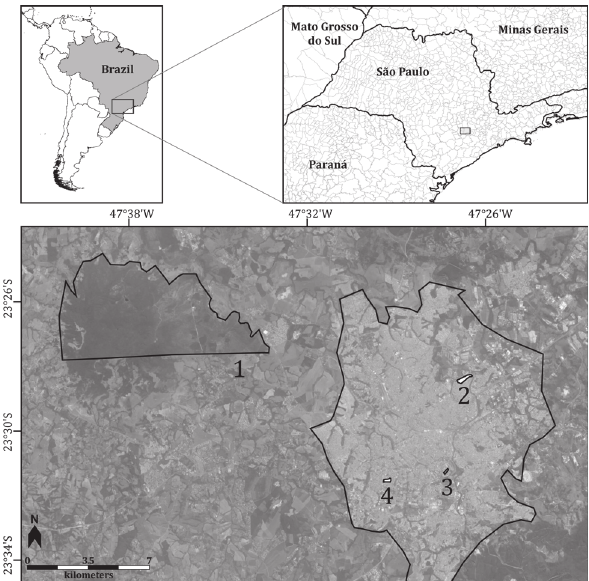
Figure 1. Map of the region of Sorocaba, southeastern Brazil, and the sampled areas. 1 = Ipanema National Forest; 2 = Parque das Águas; 3 = Parque da Biquinha; 4 = Parque da Água